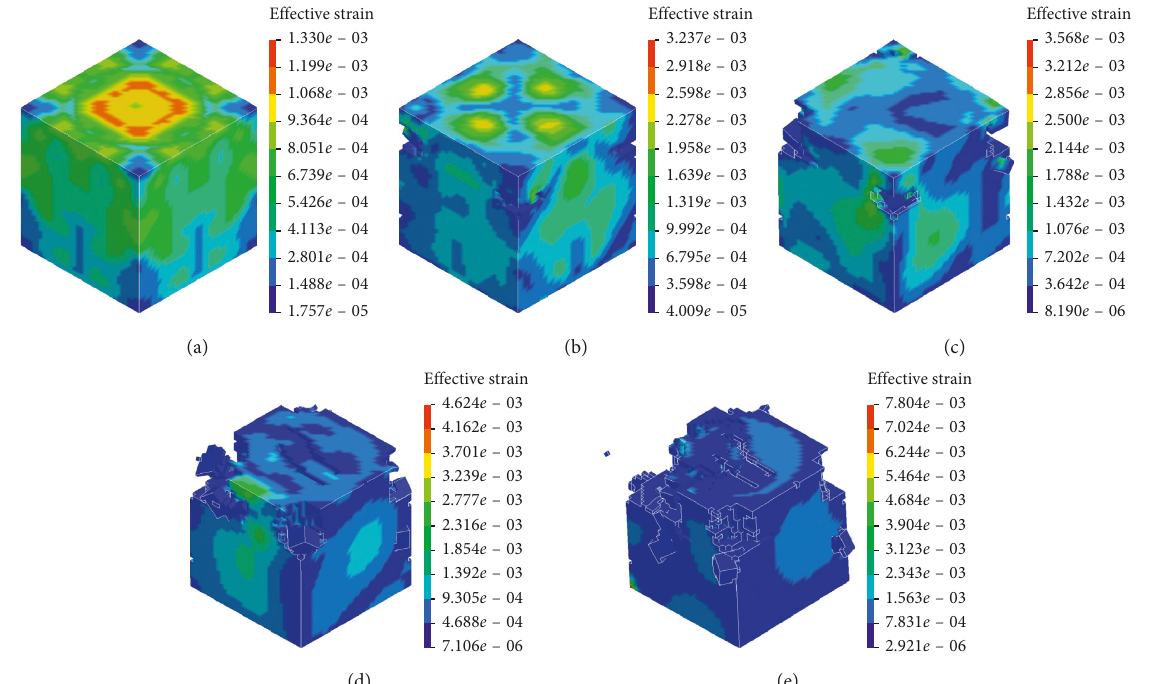
Figure 10: Effective strain of sample under cyclic impact. (a) No. 1. (b) No. 2. (c) No. 3. (d) No. 4. (e) No. 5.